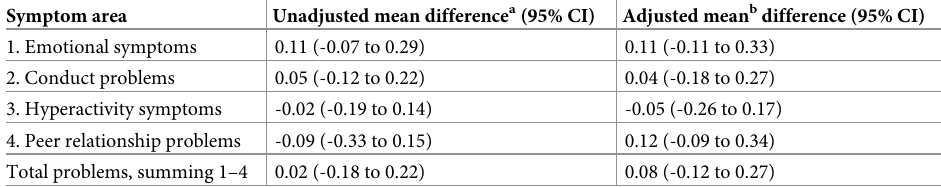
Table 4. Emotional-behavioural symptom results from the Strengths and Difficulties questionnaire, parent ver- sion. Country-pooled results showing linear regression unadjusted and adjusted models with trial arm as the depen- dent variable, N = 1048.